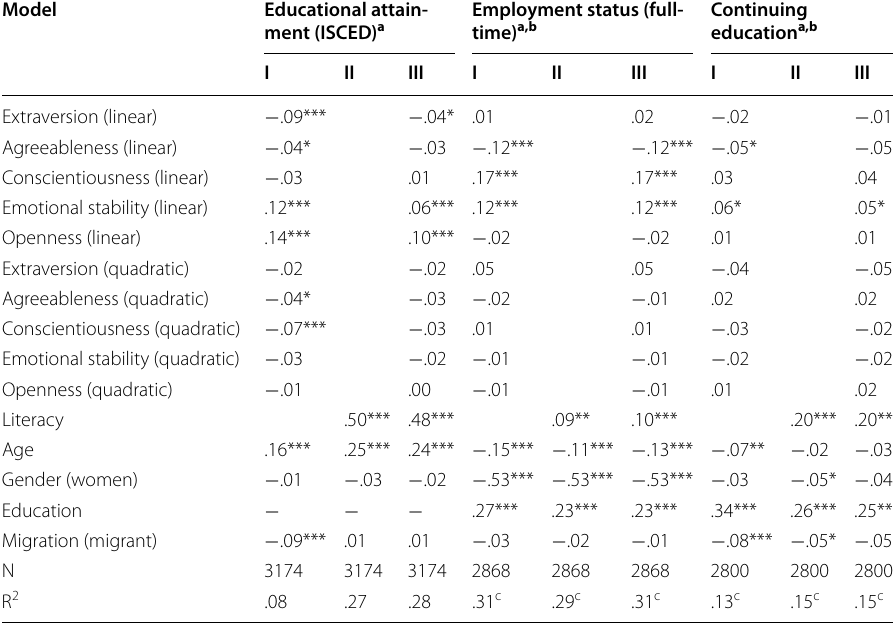
Table 6 Relationships between personality, literacy, and important life outcomes